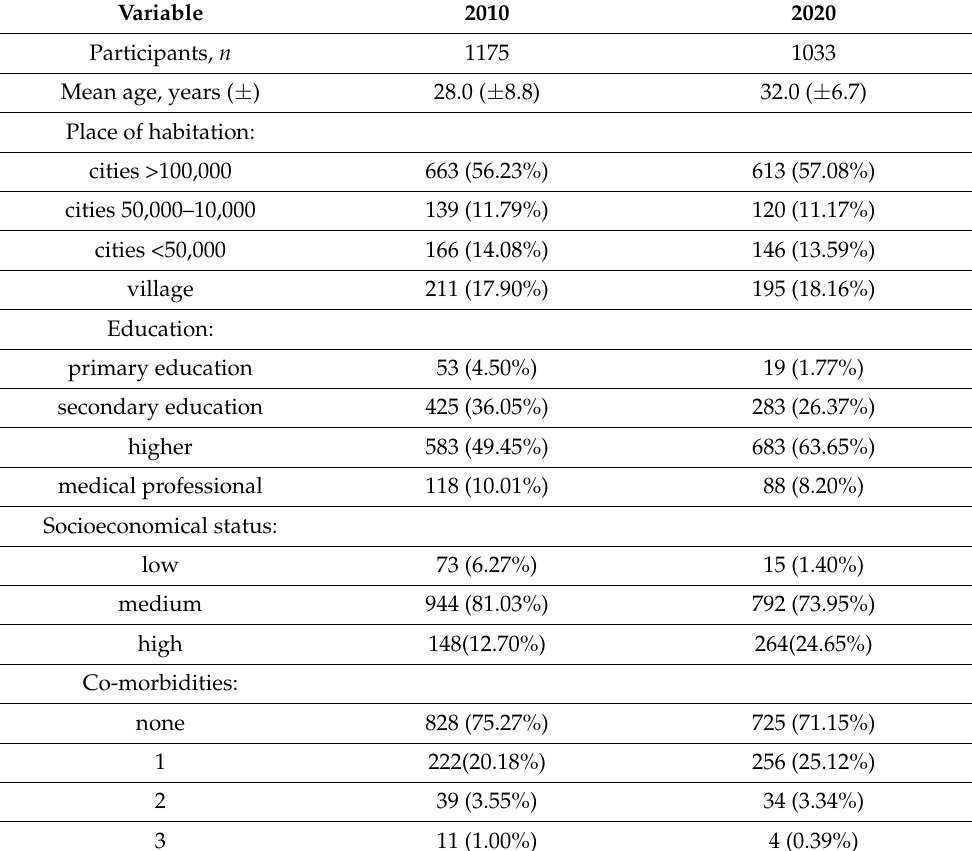
Table 1. Basic characteristics and comorbidities of the study